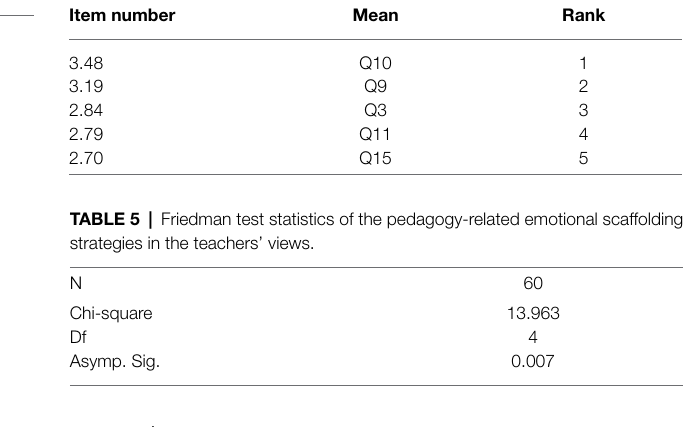
TABLE 6 | The ranks of behavior-related emotional scaffolding strategies in the teachers’ views.